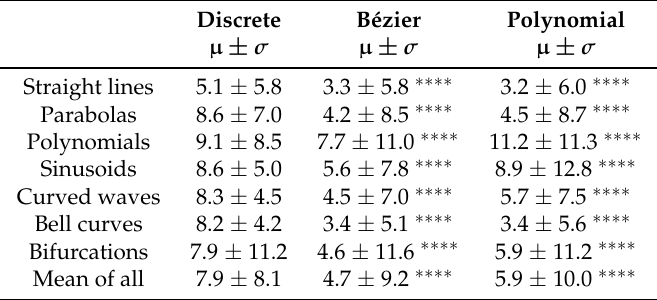
Table 5. Mean relative error of the length measurement methods in % after centerline extraction by Voronoi diagrams compared to the continuous ground truth. Significance was proven for the reduction of the error compared to the discrete length for each function type ∗∗∗∗ p < 0.0001.